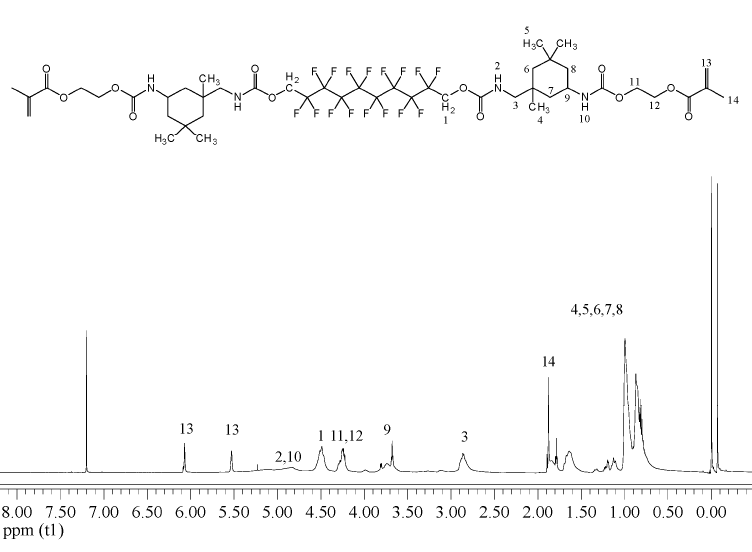
Figure 3. Proton Nuclear Magnetic Resonance ( 1 H-NMR) spectrum of FDMA. Table 1. Viscosity, double bond conversion at an irradiation time of 60 s (DC60s) and volumetric shrinkage (VS) of each resin system. Resin Formulation Viscosity (mPa ·